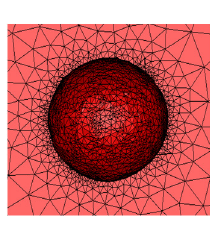
Figure 2. Model of reduction pretreatment.